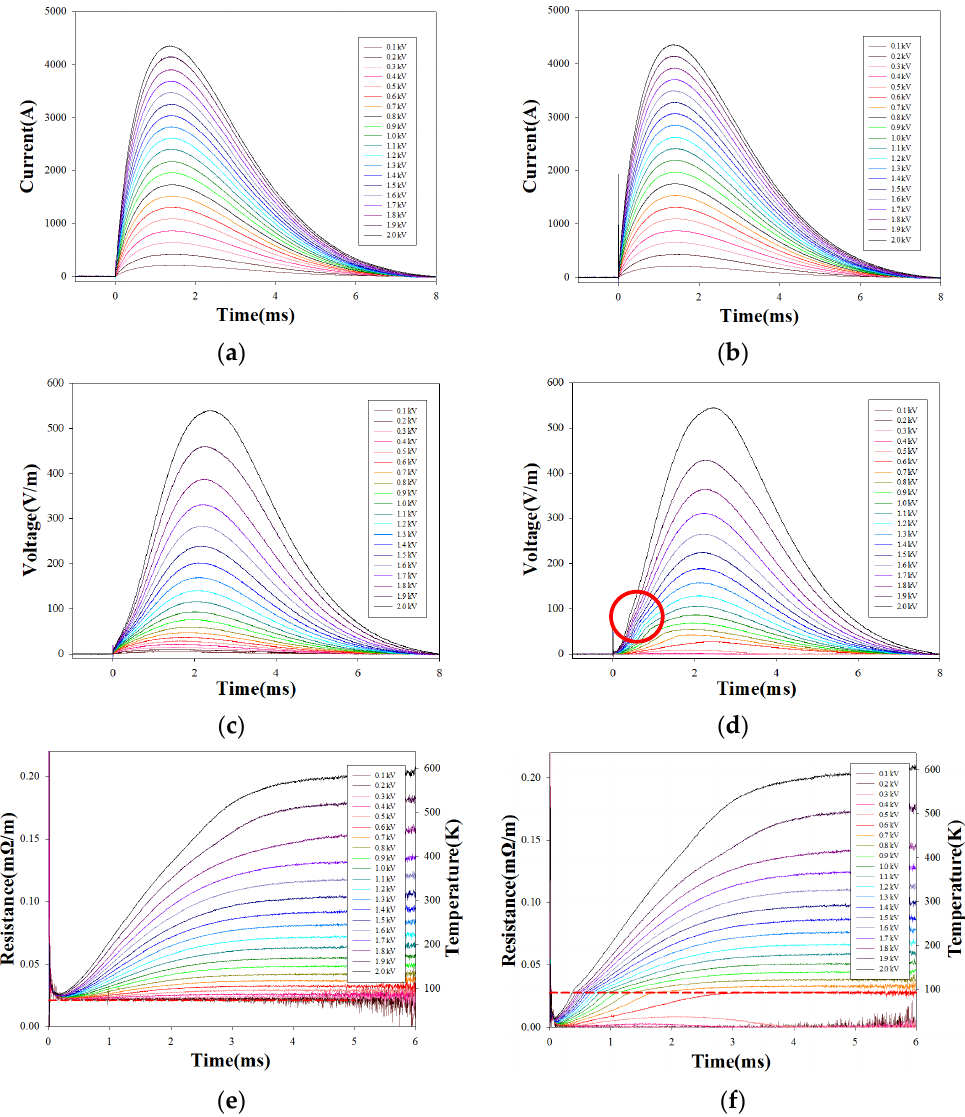
Figure 13. ( a ) Impulse current of sample 1; ( b ) impulse current of sample 4; ( c ) impulse voltage of sample 1; ( d ) impulse voltage of sample 4; ( e ) resistance response of sample 1; ( f ) resistance response of sample 4.